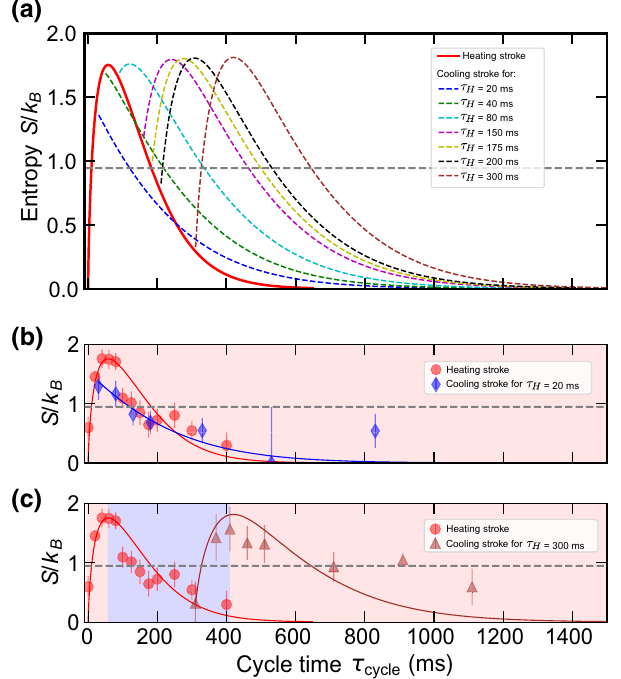
FIG. 3. The evolution of the Shannon entropy. (a) The Shan- non entropy, given in Eq. (2), as a function of the cycle time → B (red, solid) τ cycle : the behavior for the heating stroke A and for the cooling stroke C → D (other colors, dashed). The times in the legend indicate the heating time τ H . The initial state | m F ,Cs = + 3 (cid:2) is fully polarized (see Fig. 2) and leads to an initial zero entropy. Large heating times populate the system in | m F ,Cs = − 3 (cid:2) , giving a low entropy again. The maximum is reached for a mostly spread spin distribution, which is theoreti- cally reachable for a population of 1 / 7 in each of the seven states. The population of highly excited states during heating leads to a second entropy maximum while cooling. Short heating times do not lead to the double-peak structure. (b) The evolution of the Shannon entropy for a short heating time τ H = 20 ms. The dots show the data for the heating stroke and the diamonds those for the cooling stroke. The solid lines are simulations based on our spin-exchange model. The horizontal dashed lines mark the entropy of cycle points B and C when the engine is running at full power. (c) The evolution of the Shannon entropy for a large heating time τ H = 300 ms. The dots show the data for the heat- ing stroke and the triangles those for the cooling stroke. One can see that for the longer time, the system operates in the negative- temperature regime between the two entropy peaks, which is not crossed for the shorter time. Atomic losses cause deviations from the simulation for very large